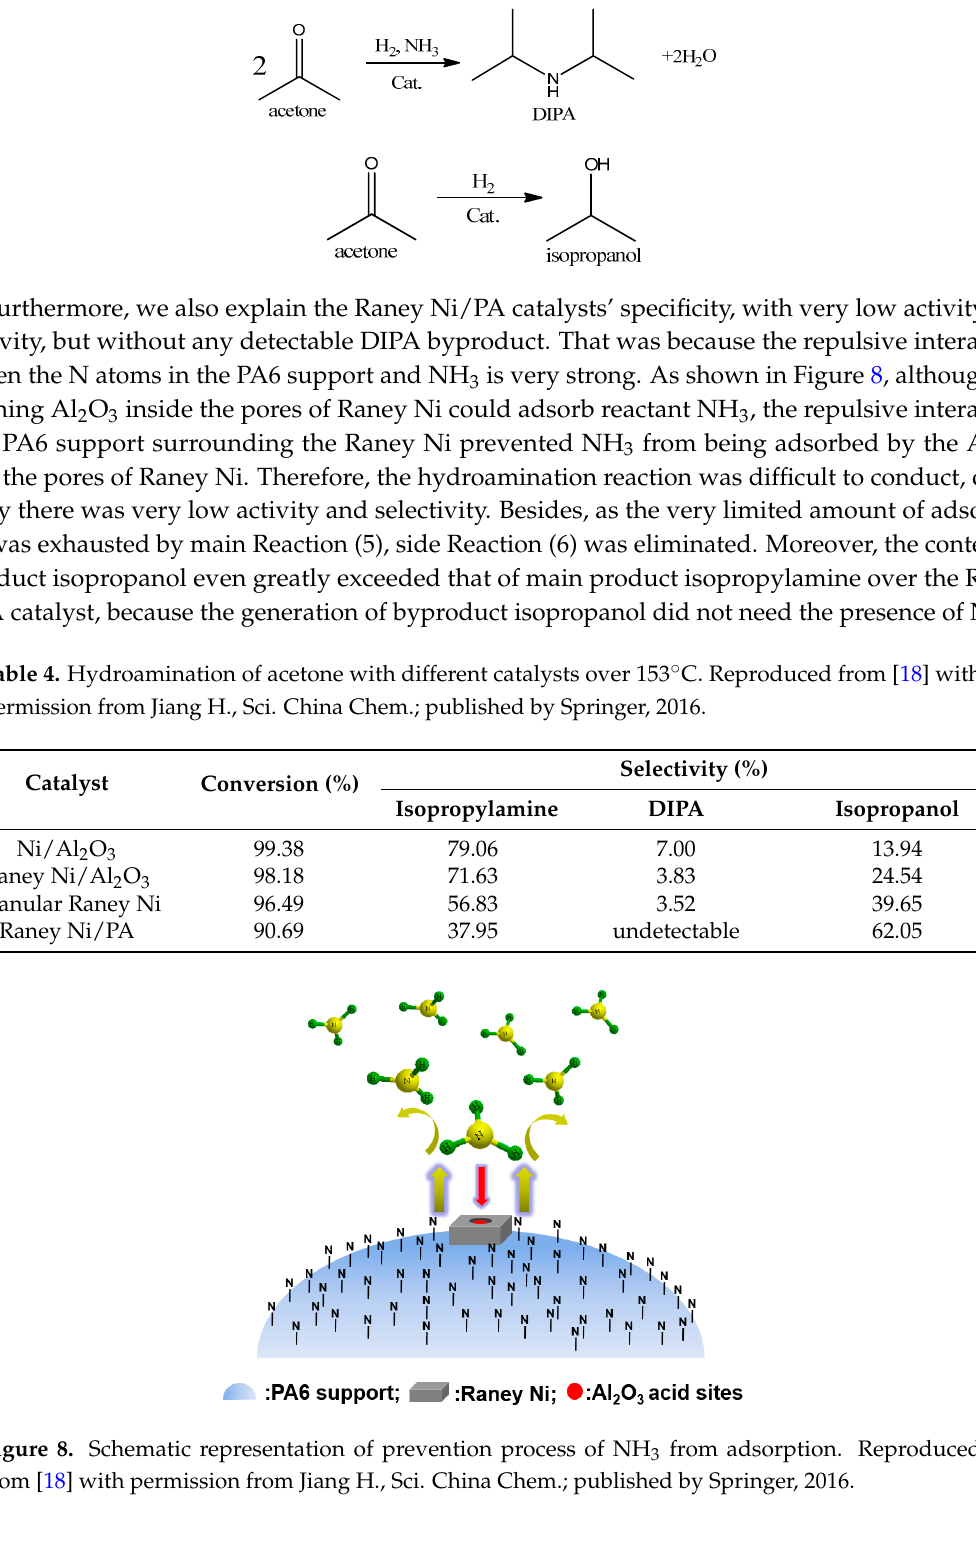
7 of 11 Figure 6. Schematic representation of generation process of byproduct MIBC. Reproduced from [18] with permission from Jiang H., Sci. China Chem.; published by Springer, 2016. Figure 7. Schematic representation of elimination of MIBC over Raney Ni/PA catalyst. Reproduced from [18] with permission from Jiang H., Sci. China Chem.; published by Springer, 2016. 5. Application of Polymer-Supported Raney Catalysts in Hydroamination of Acetone to Isopropylamine It was obvious that the basic N atoms in the PA6 support having strong interactions with reactants plays a key role in the clean preparation of both n -butanol and isopropanol. In order to confirm the above conclusion, we studied the hydroamination of acetone to isopropylamine [18]. Similarly, this reaction has two main side reactions, which generate the byproducts diisopropylamine (DIPA) and isopropanol, respectively (see Reactions (5)–(7)). We found that conversion, selectivity, and byproduct contents over the four catalysts displayed a monotonically changing relationship (see Table 4). The support-effect model proposed in the clean preparation of n -butanol was again successfully used to explain the reaction results. NH